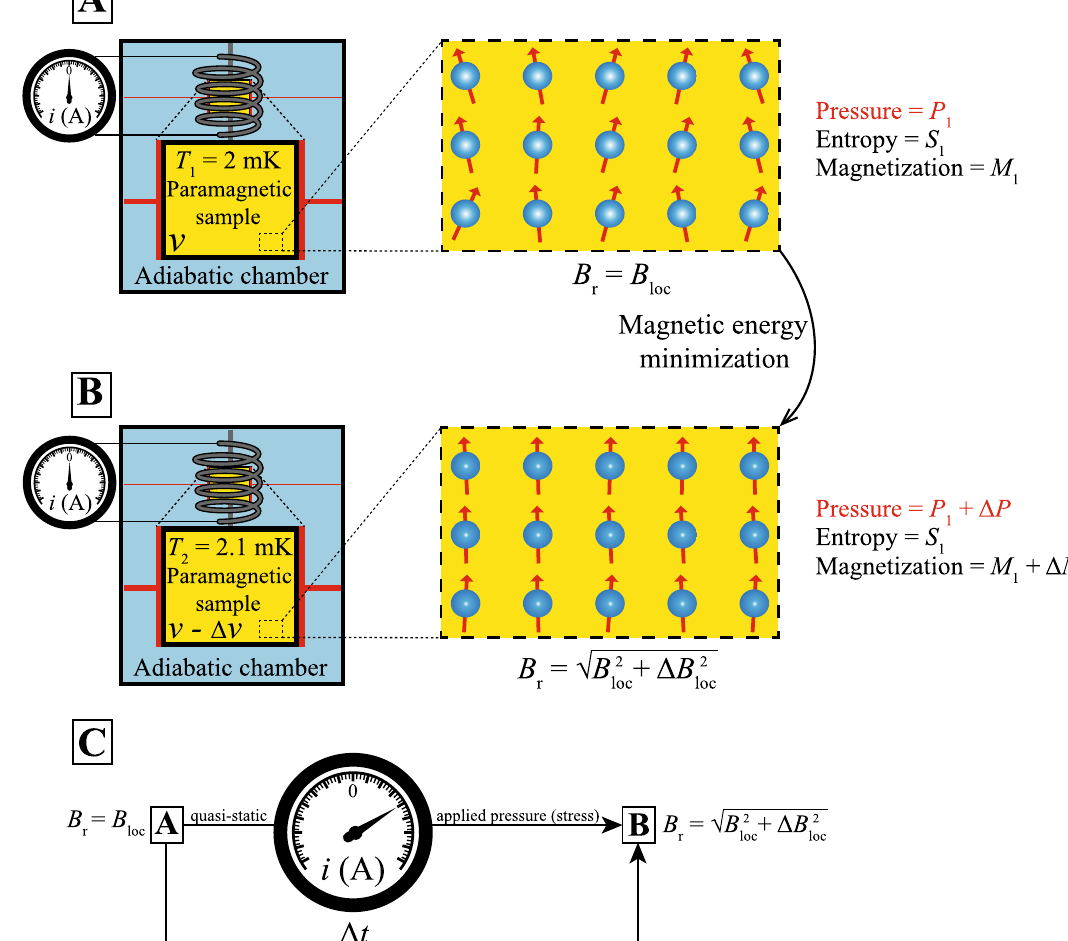
Figure 2. Schematic representation of the steps for performing the adiabatic magnetization of a paramagnetic specimen 7 . ( A ) A sample with volume v is inserted inside a coil, which is attached to an ampere meter, into an 2 mK, being the sample under pressure p 1 , with adiabatic chamber and the temperature is decreased to T 1 = entropy S 1 , and magnetization M 1 . External magnetic fields are absent and thus the resulting magnetic field B r B loc due to the intrinsic mutual interactions between adjacent magnetic moments (represented by the red = arrows). The dashed lines represent a zoom of the paramagnetic sample inside the coil and the spins inside the sample. ( B ) A quasi-static pressure, more specifically the stress as depicted in Fig. 3, is applied so that the volume 2.1 mK. The is reduced by a factor (cid:31) v , leading thus to an adiabatic increase of the sample temperature to T 2 = (cid:31) p ) and it is magnetized by a factor (cid:31) M in order to hold the entropy sample is now under a pressure ( p 1 + S 1 constant. Since the magnetization of the sample is increased (minimization of the energy, cf. discussions in (cid:31) B loc 2 . B loc 2 the main text), the spins are slightly vertically aligned since now the resulting field is B r ≃ + ( C ) During the time interval (cid:31) t from process A to B (quasi-static applied pressure, i.e., stress cf. Fig. 3), the (cid:31) magnetic field is increased from B loc